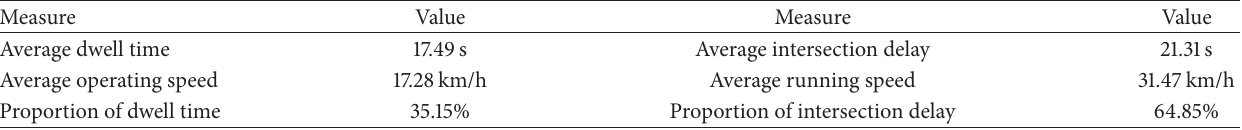
Table 1: Average operating data of Shanghai, Tianjin, and Dalian streetcar systems.